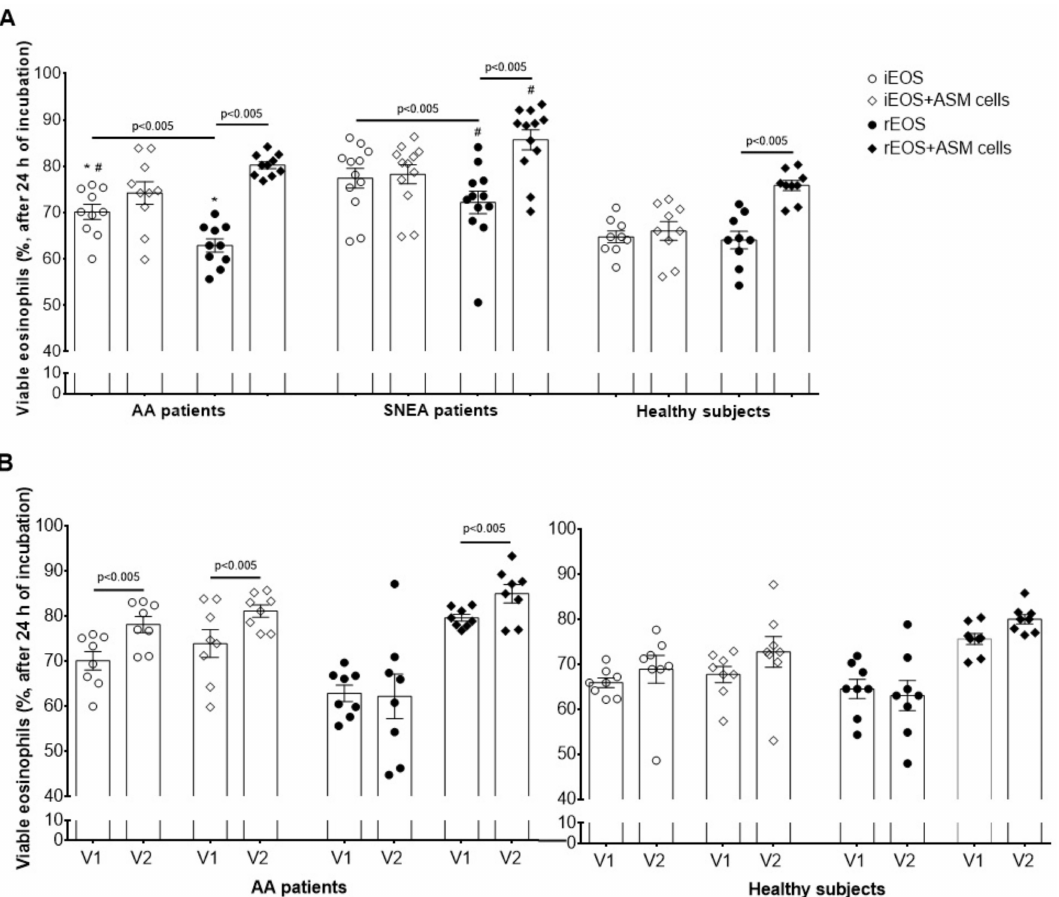
Figure 6. Viability of blood eosinophils subtypes. ( A ) The viability of blood eosinophils subtypes at baseline; ( B ) the viability of blood eosinophils subtypes after bronchial allergen challenge. The results are presented as mean ± S.E.M. AA—allergic asthma; iEOS—inflammatory eosinophils; rEOS—lung-resident eosinophils; SNEA—severe non-allergic eosinophilic asthma; V1—visit 1 (before bronchial allergen challenge); V2—Visit 2 (24 h after bronchial allergen challenge). The results from independent experiments of: Part ( A ) AA n = 10, SNEA n = 12, HS n = 9; Part ( B ) AA n = 8, HS n =